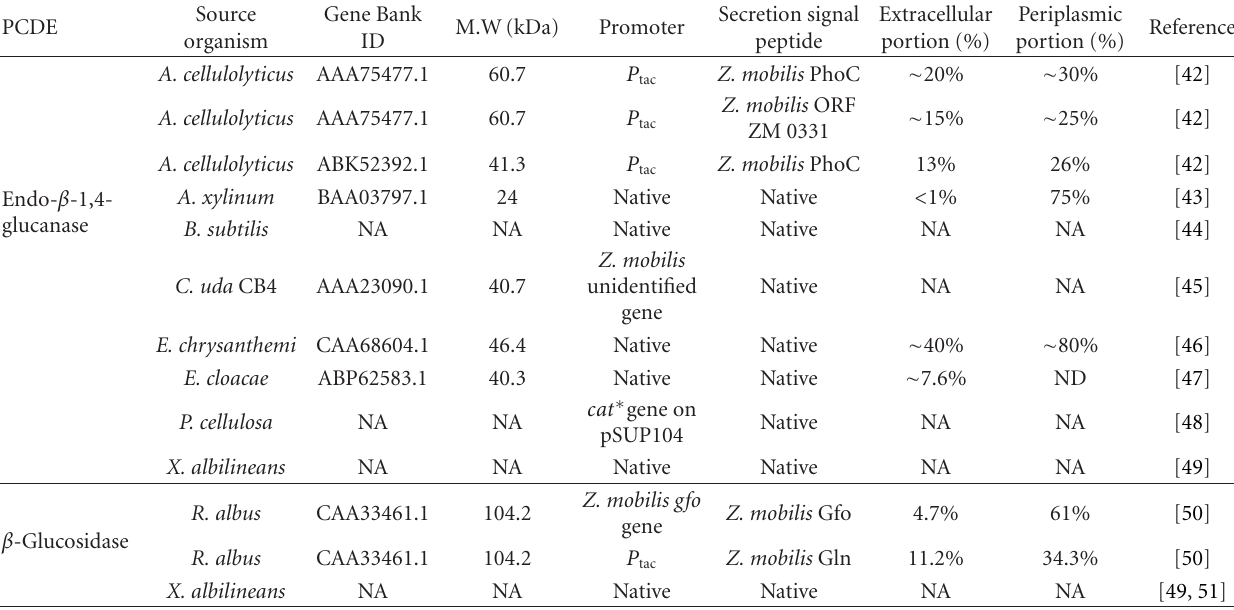
Table 1: Summary of expression of plant cell wall degrading enzymes in Z.